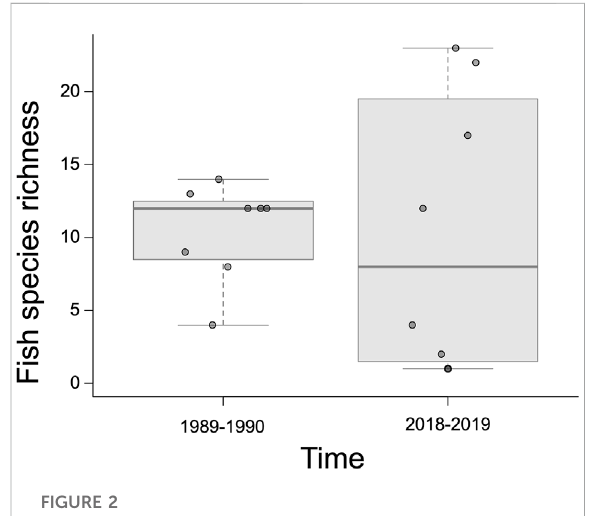
FIGURE 2 Boxplot of fi sh species richness between the 1989 – 1990 and 2018 – 2019 surveys.